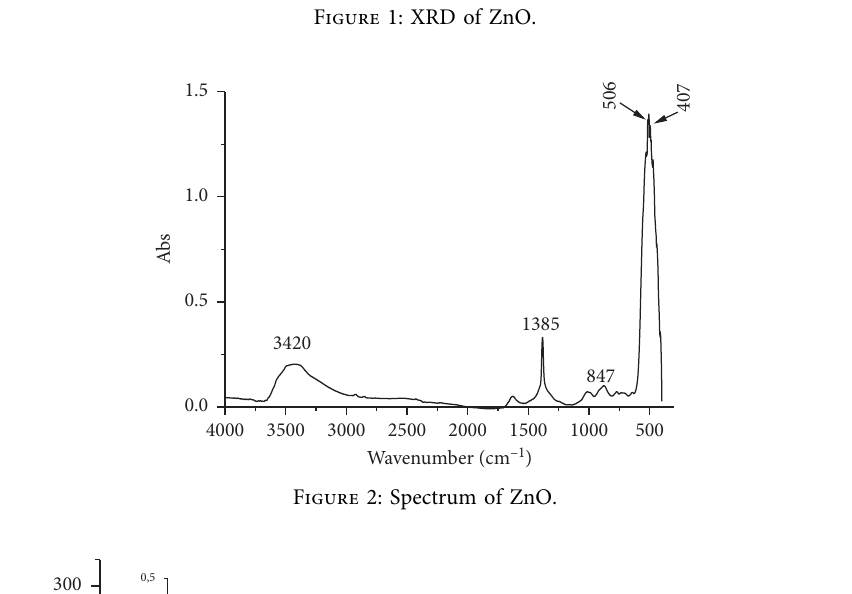
Figure 1: XRD of ZnO.